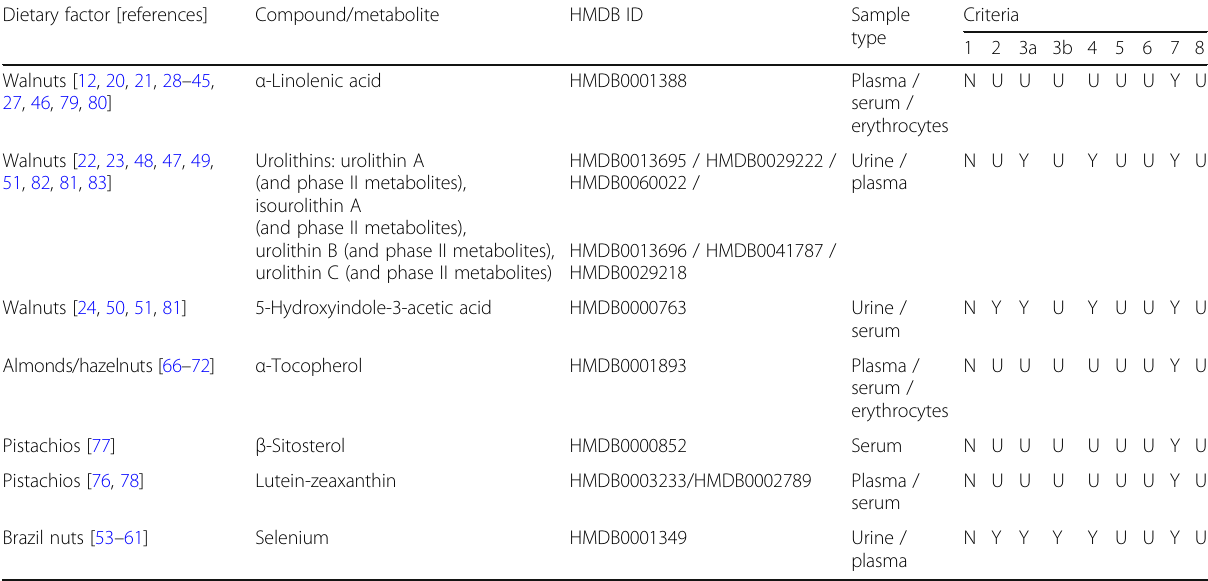
Table 2 Validation scheme of potential food intake biomarkers for nuts Dietary factor